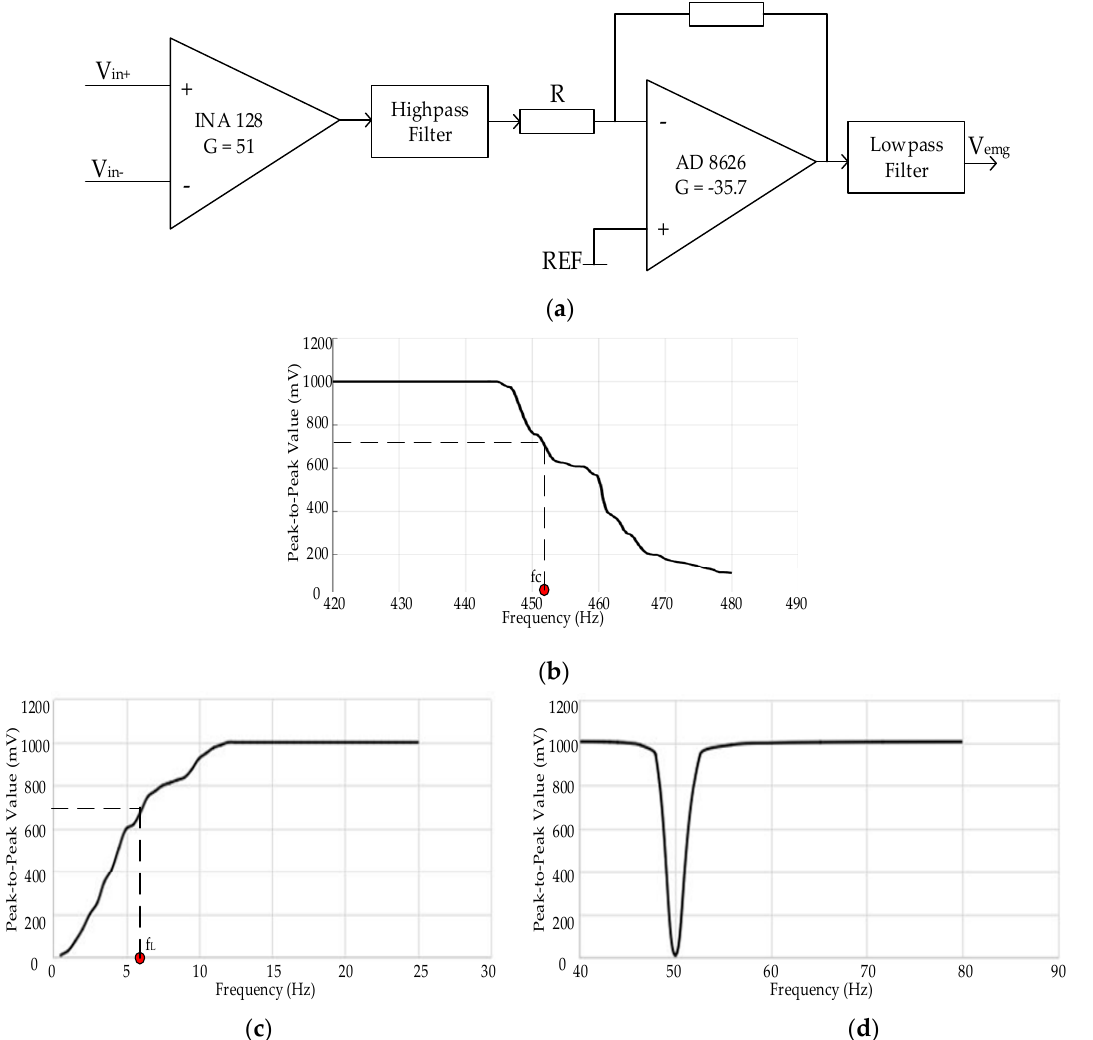
Figure 6. ( a ) is the system electrical schema of amplifiers and filters, ( b – d ) are the amplitude-versus- frequency curves of low-pass filter with the cut-off frequency fc, high-pass filter with the cut-off frequency f L , and notch filter of 50 Hz, respectively.